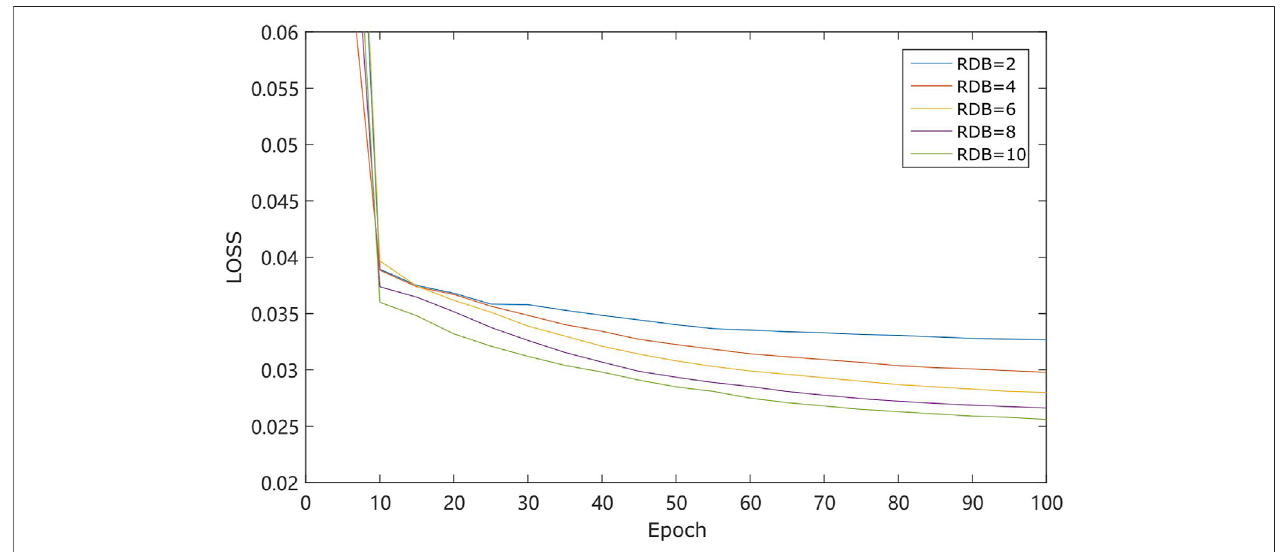
FIGURE 2 | The mean square error loss